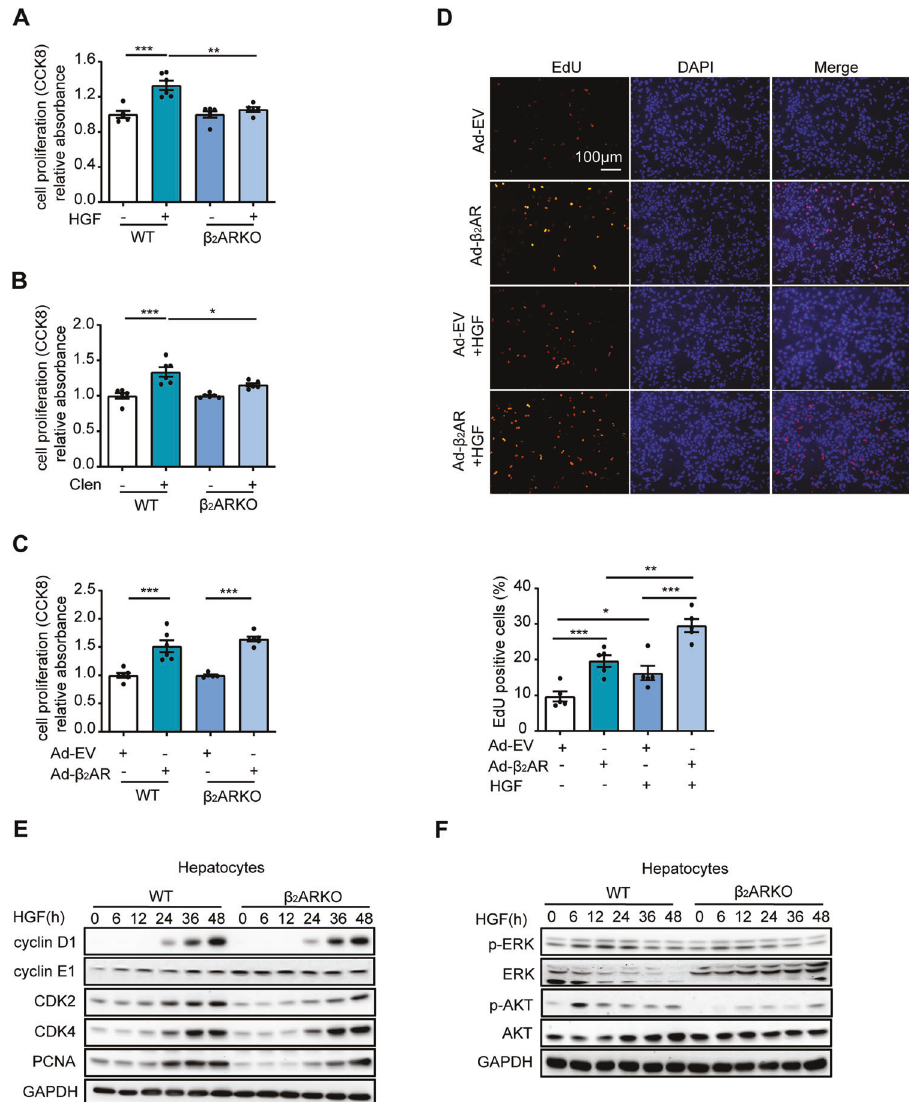
β 2 AR- and Ad-EV-treated hepatocytes